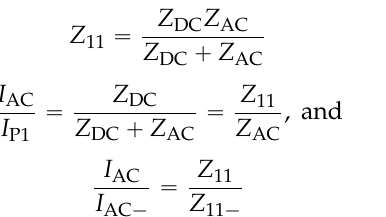
Figure 11. Current source equivalent circuit.